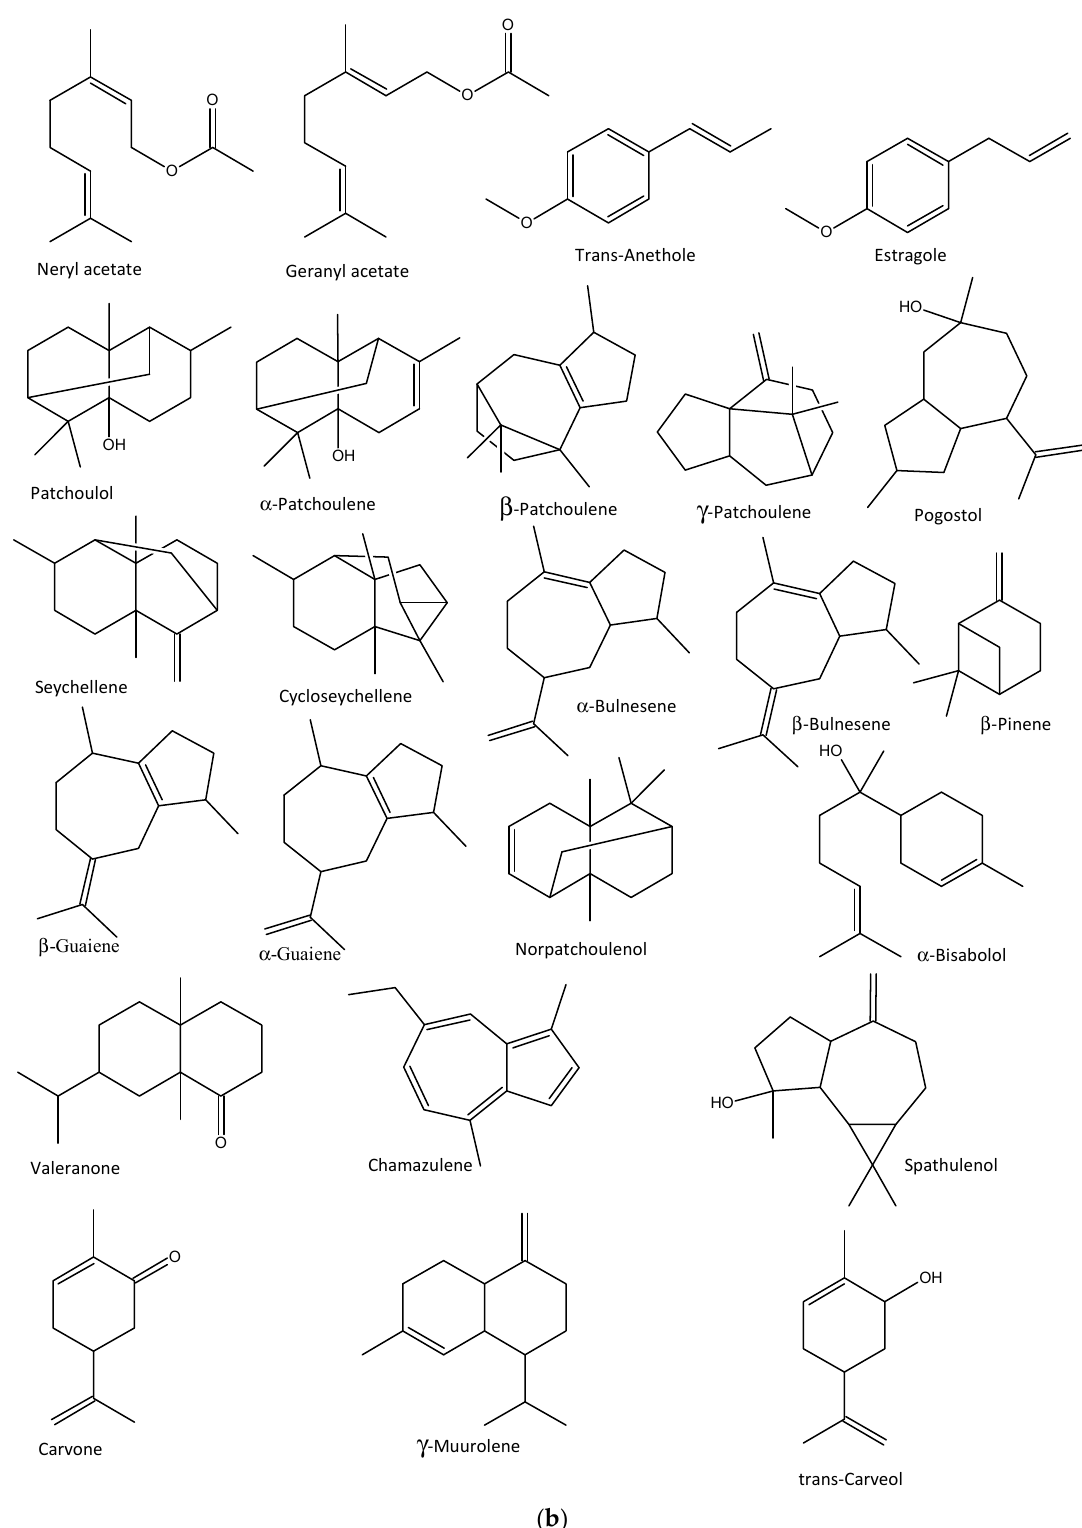
Figure 3. Structures of some bioactive essential oil compounds ( a and b ) that have been implicated against some influenza viruses.